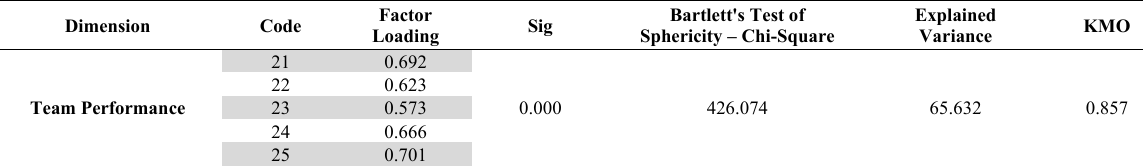
EFA analysis for the items representing the Dependent Variable (Team Performance) Dimension Code